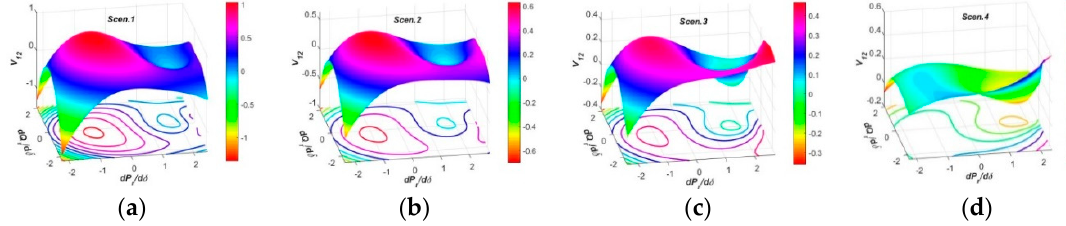
Figure 13. Spatial surfaces of PFG to CIV2 at SCP4 in spaces: ( a – d ) Spatial surfaces of PFG to CIV2 in four regulation scenarios.